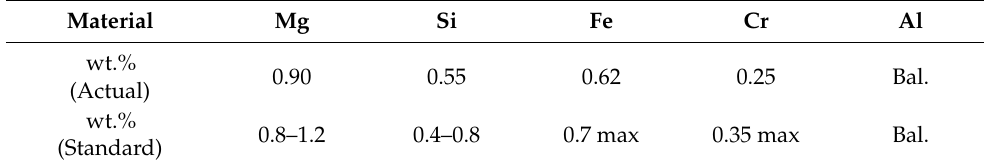
Table 1. Chemical composition of Al6061 alloy.